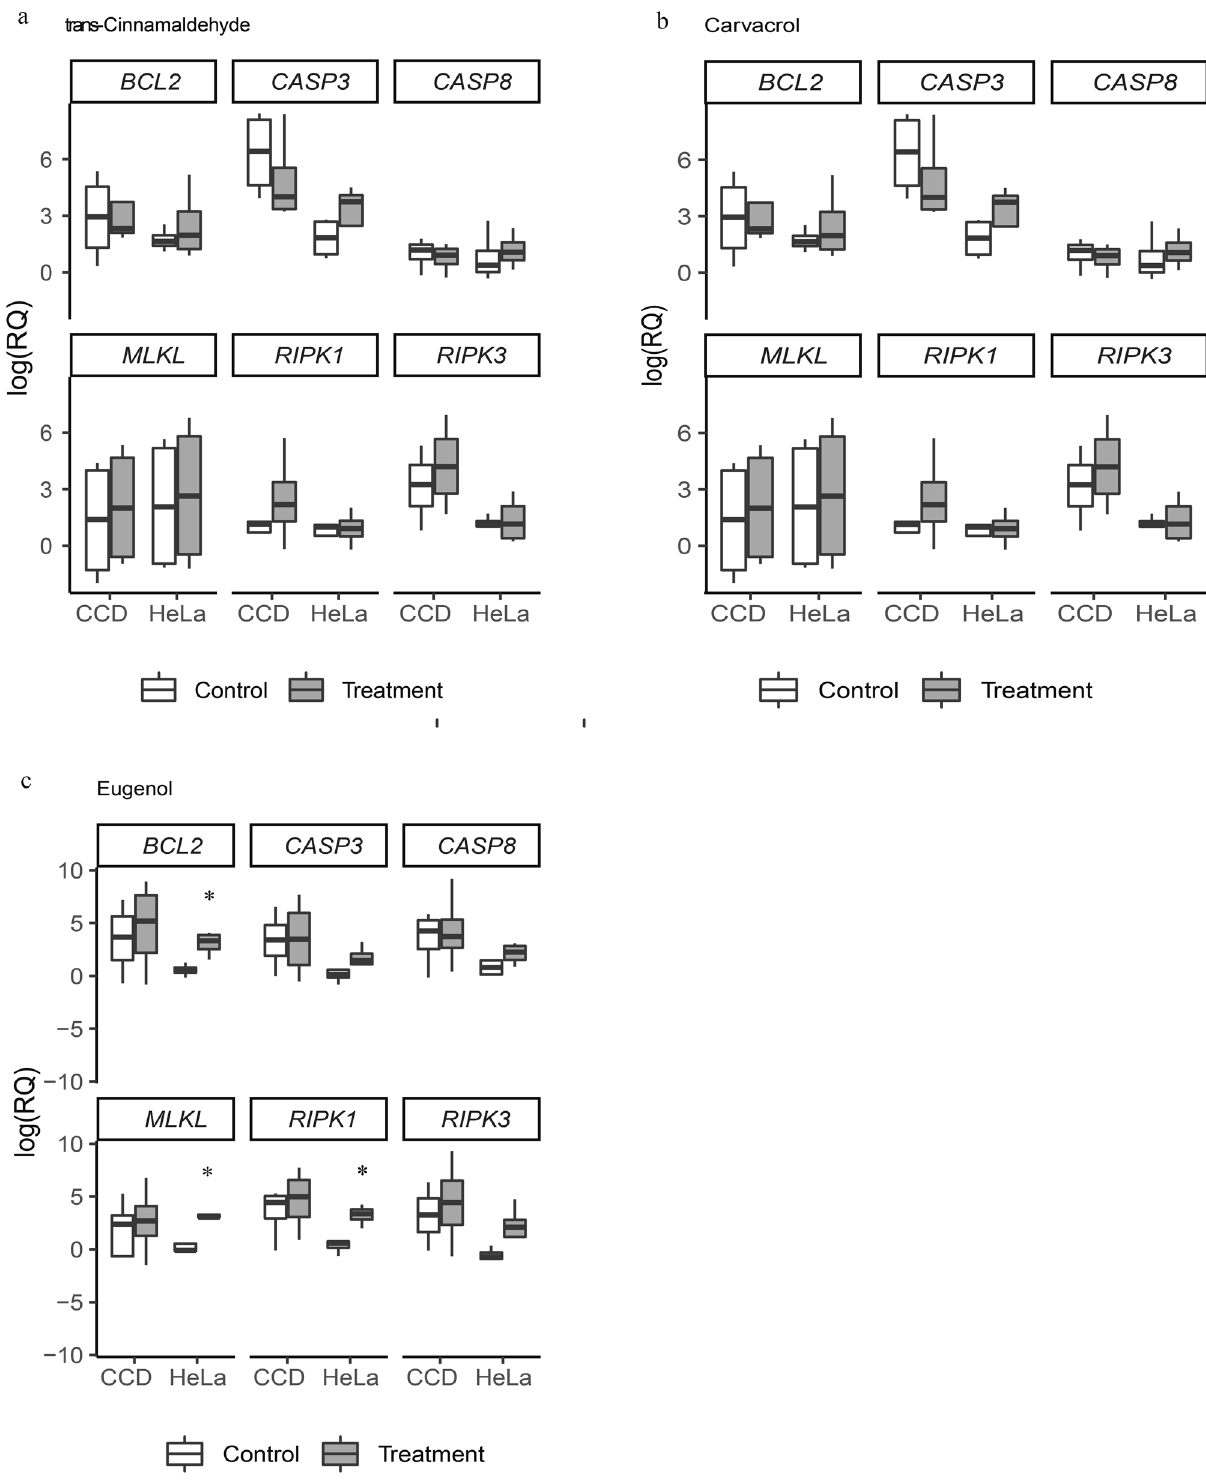
Figure 4. Relative levels of mRNAs for apoptotic and necrotic genes in HeLa and CCD cells treated with ( a ) TC, ( b ) CAR, and ( c ) EU. Expression levels are expressed in log (RQ, relative quantity) values. Asterisk (*) represents a significant difference between control and